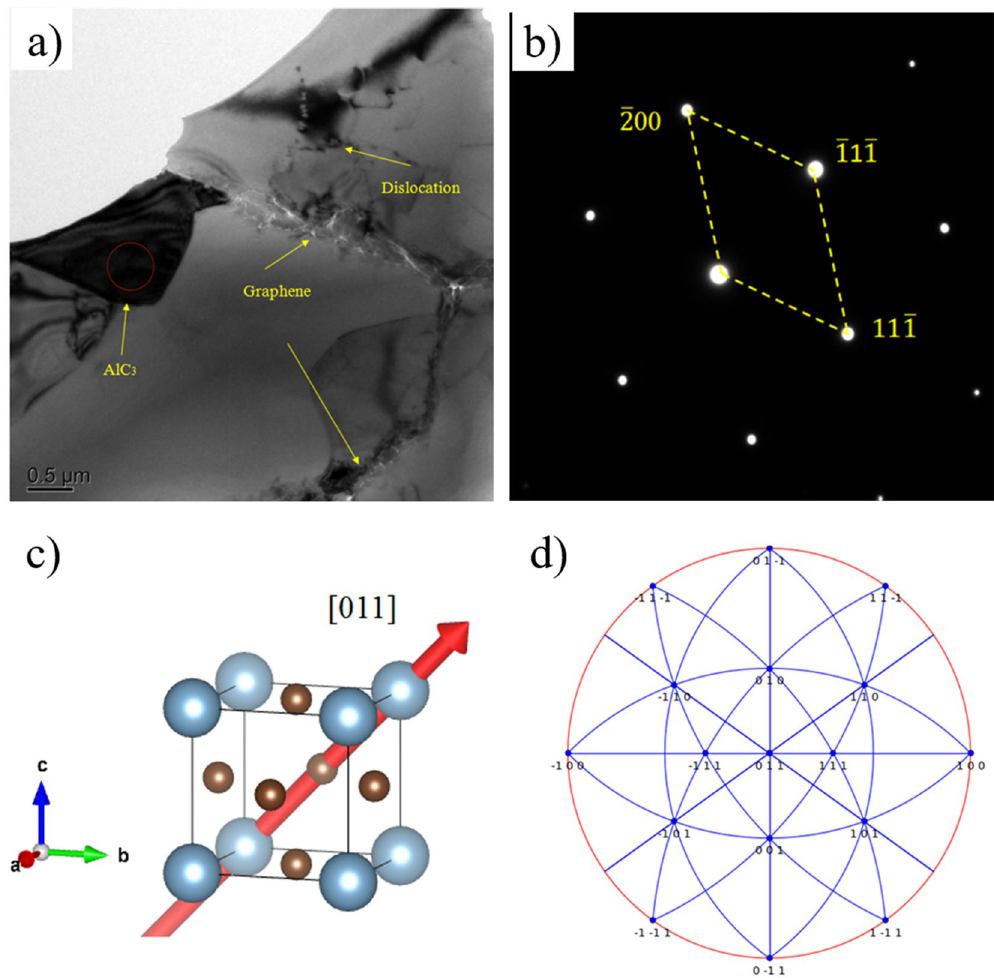
Figure 4. Representative microscopic structure of aluminum matrix composites ( a ) microstructure morphology; ( b ) diffraction pattern of AlC 3 ; ( c ) crystal belt axis of [011] direction; ( d ) the stereographic projections of [011]